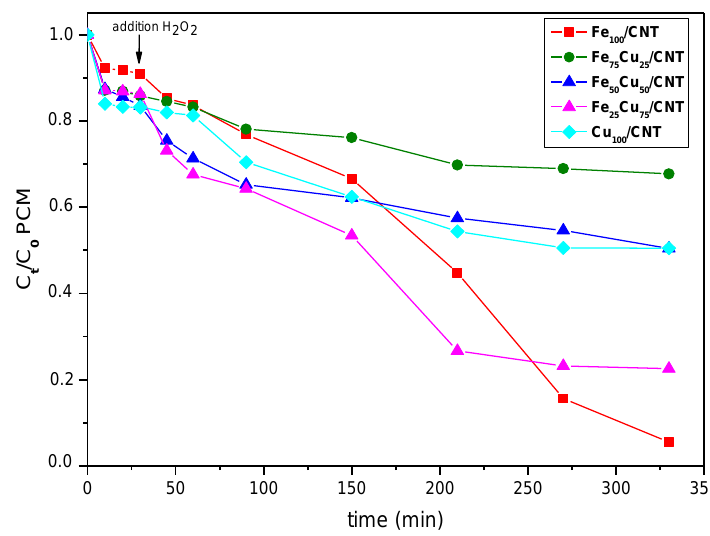
Figure 8. Decomposition kinetics of paracetamol (PCM; C 0 = 50 mg / L) at 25 ◦ C on Fe 100 − x Cu x / CNT samples. C 0 of H 2 O 2 : 6.9 × 10 − 3 mol / L. Initial pH: 6.3–6.6.